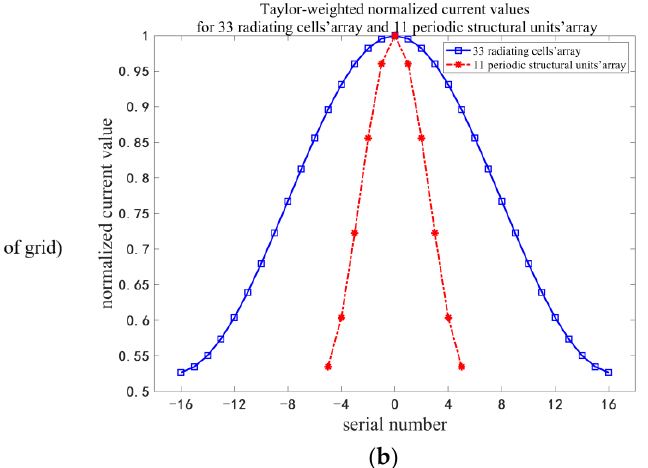
Figure 2. ( a ) The periodic structural unit; ( b ) Taylor-weighted normalized current distributions for 33 radiating cells’ array and 11 periodic structural units’ array.